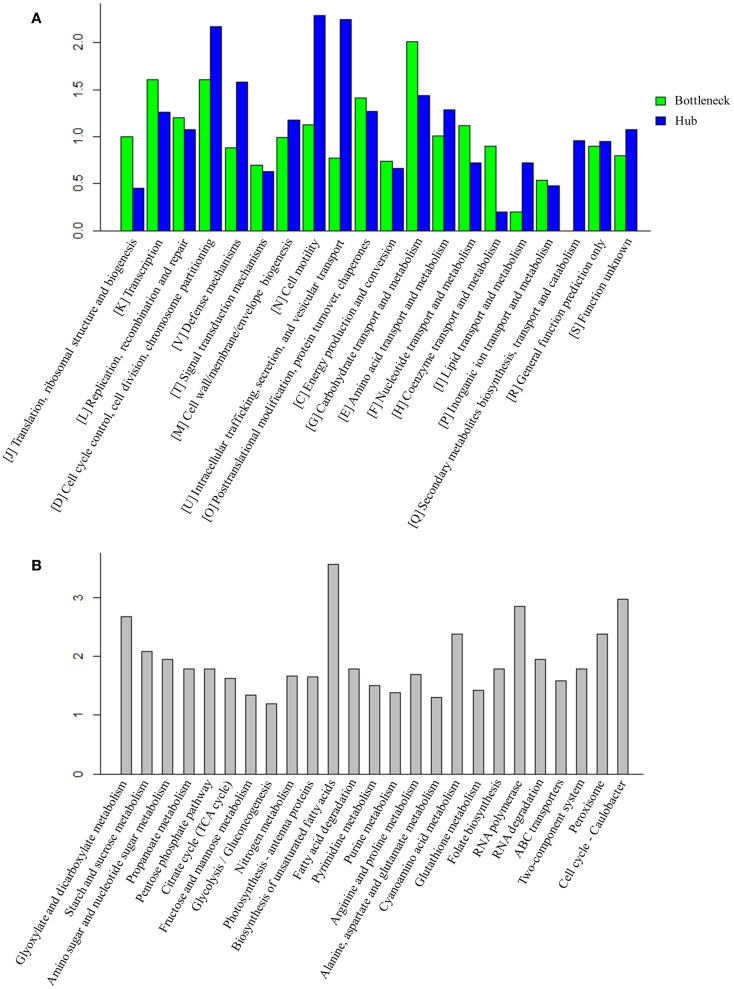
Function analysis of bottlenecks and hubs proteins. (A) COG enrichment analysis of bottlenecks and hubs proteins. X-axis indicates the COG category and Y -axis indicates the ratio compared to background. (B) KEGG metabolic pathways enrichment analysis of bottlenecks and hubs proteins. Top 25 metabolic pathways are listed and ordered by function category. X-axis indicates the names of pathway and Y -axis indicates the ratio compared to background.